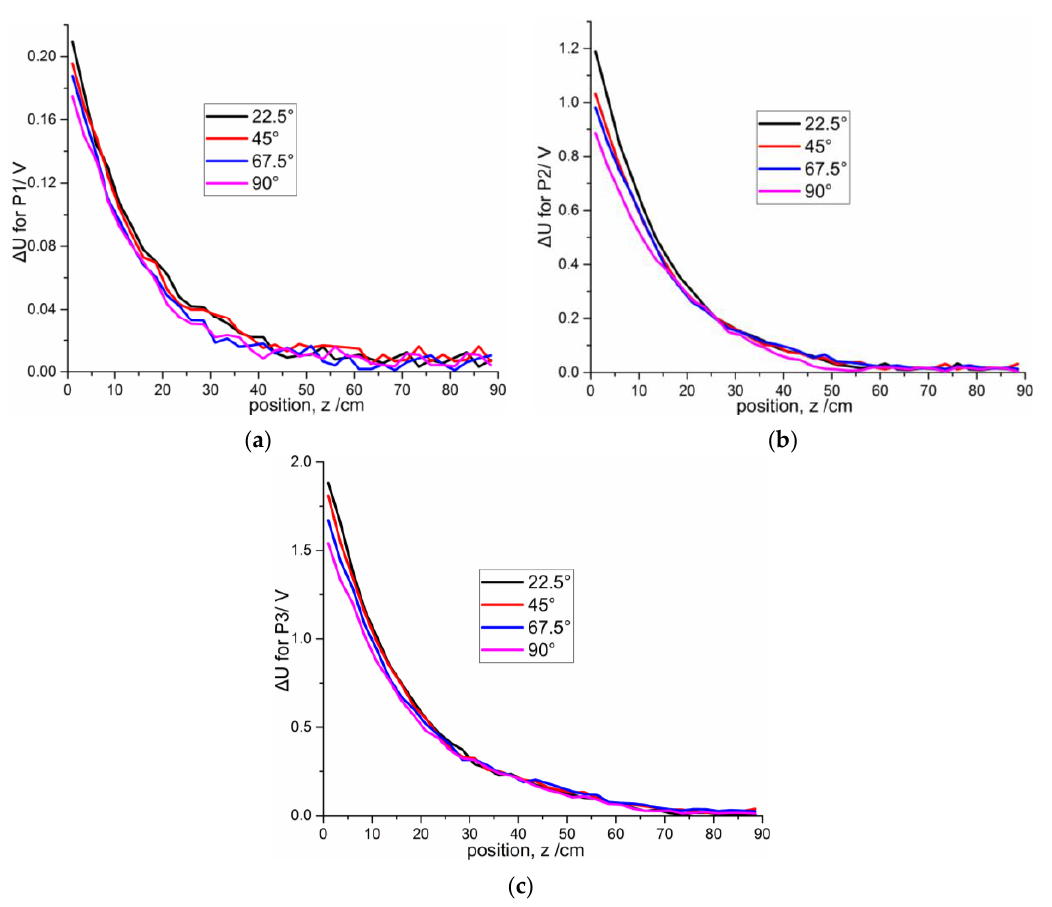
Figure 17. Comparisons of different attack angles for three projectiles with distance from 1 cm to 88.5 cm at intervals of 2.5 cm: ( a ) P1; ( b ) P2; ( c ) P3.